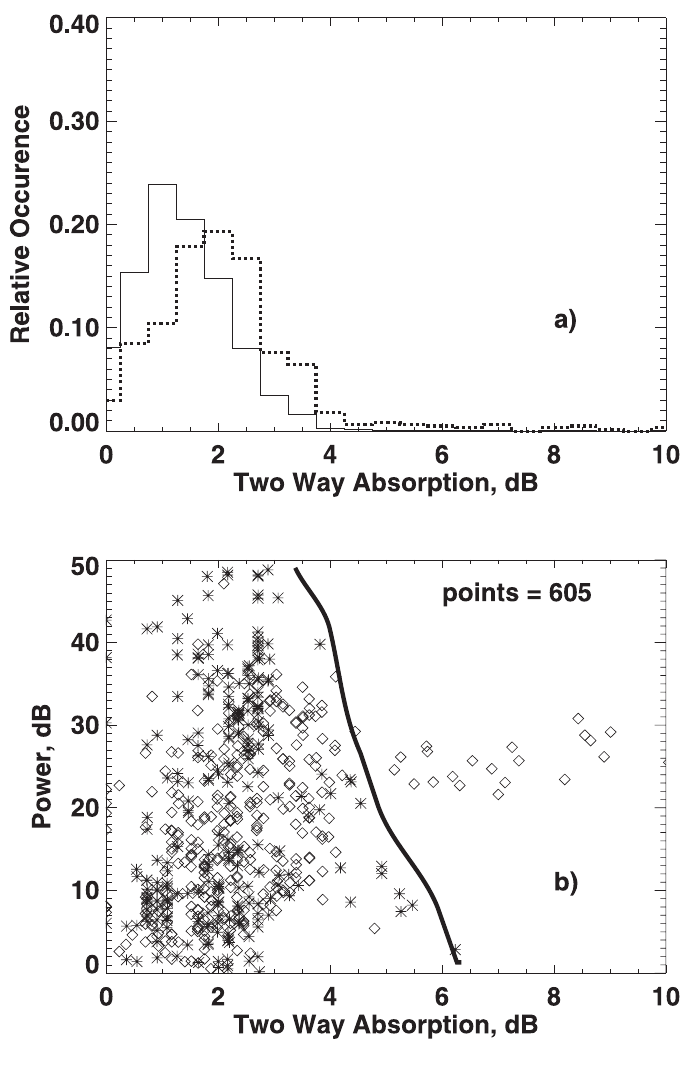
Fig. 5. (a) Histogram of the relative oc- currence of riometer absorption at Oulu for all four days (solid line) and for all times when HF ionospheric echoes were received (dotted line). (b) Scatter plot of HF echo power in bin 16 ver- sus D-region absorption at slant range of ∼ 350km obtained from the origi- nal riometer records at Oulu, the closest station to the entry point of radar waves into the D-region (605 points). Aster- isks (diamonds) correspond to observa- tions at 10.0